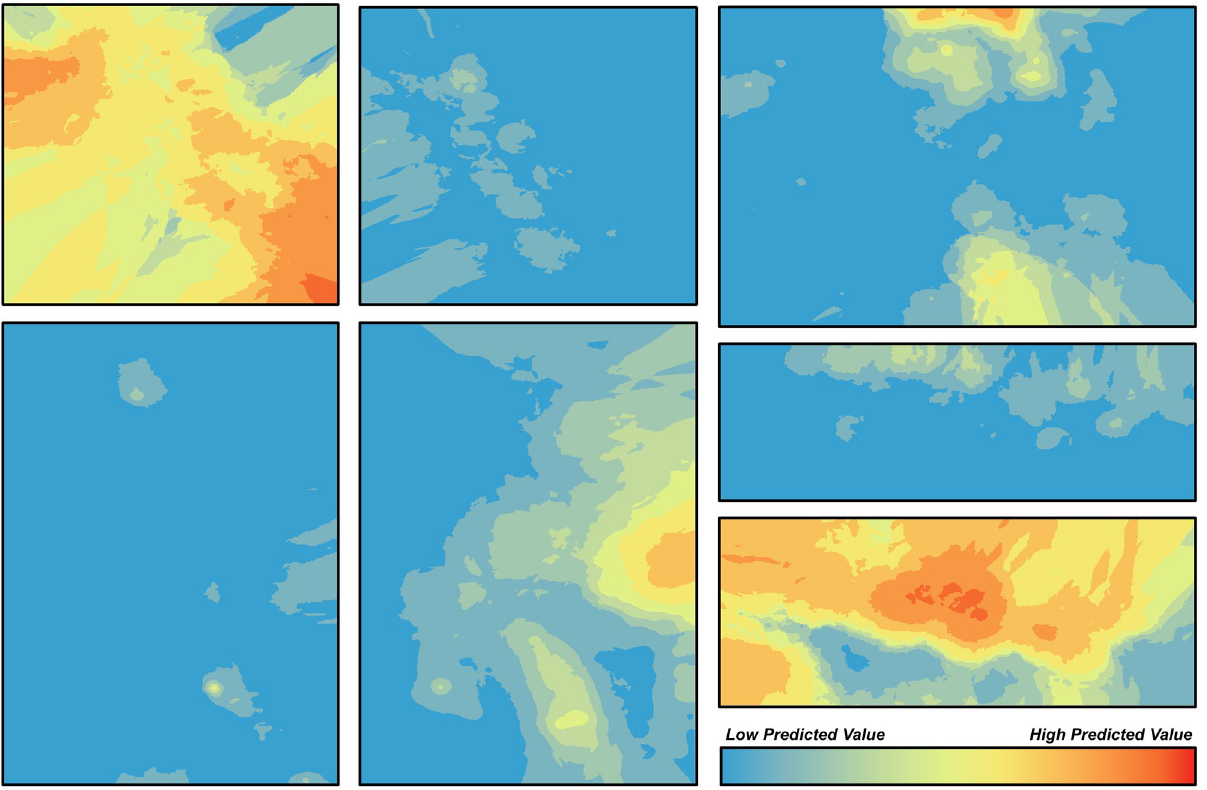
Figure 5. Empirical Bayesian Kriging (EBK) interpolation of spotted lanternfly (SLF) egg mass densities within vineyard blocks across 7 vineyards. Each square indicates a single vineyard block. Darker (red) colors indicate higher predicted density of SLF adults, whereas lighter colors (blue) indicate lower predicted